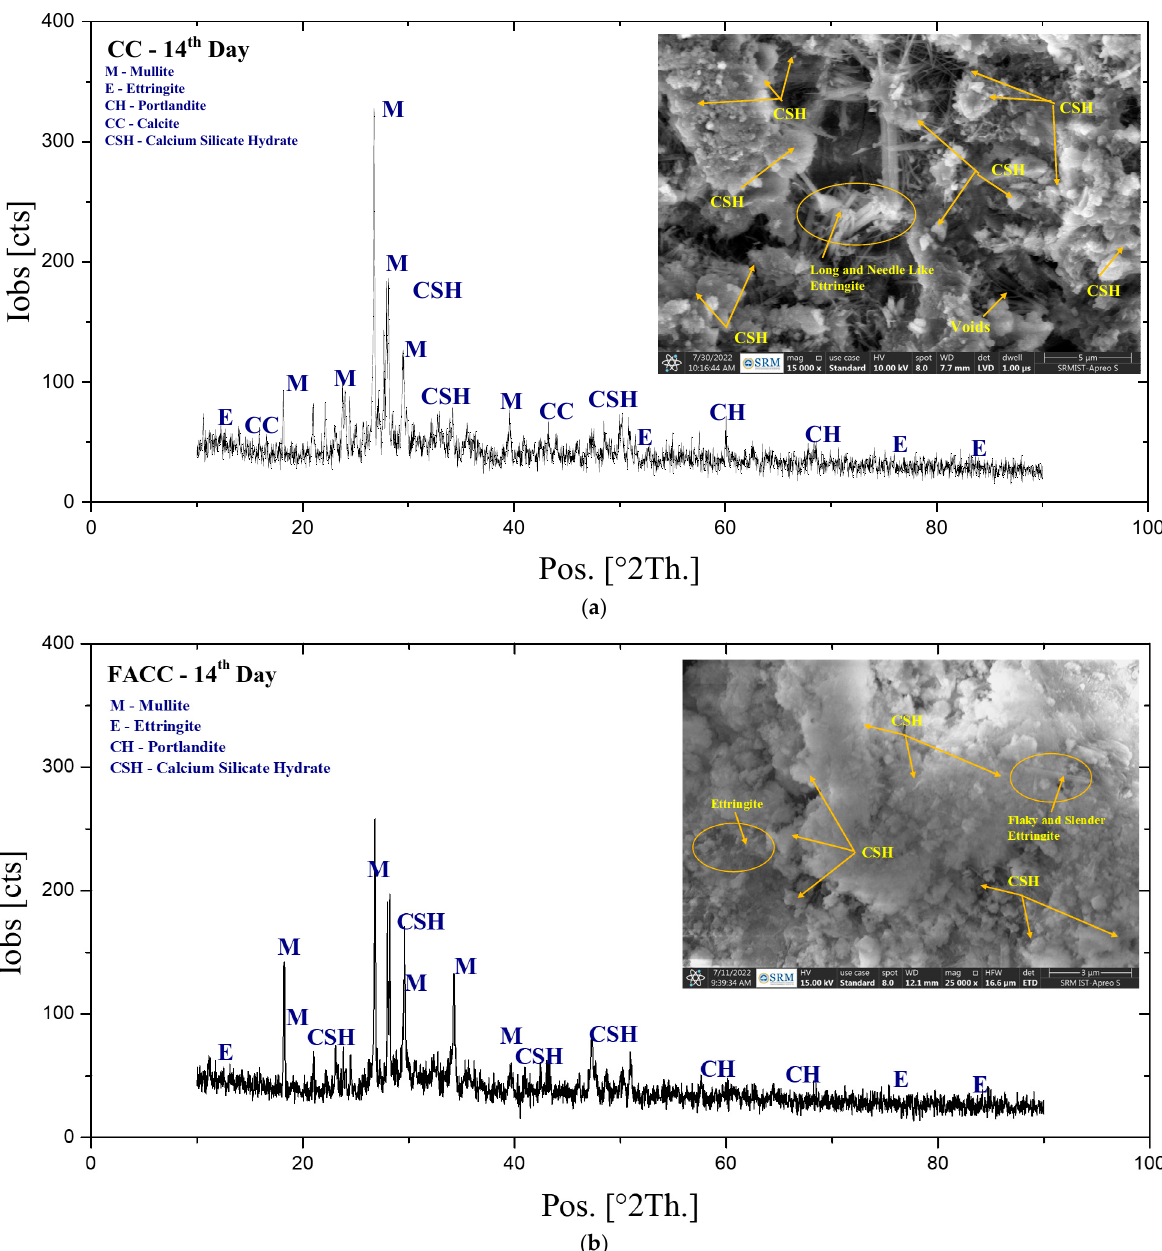
Figure 12. XRD and SEM ( a ) CC ( b ) FACC on the Fourteenth Day of Testing.